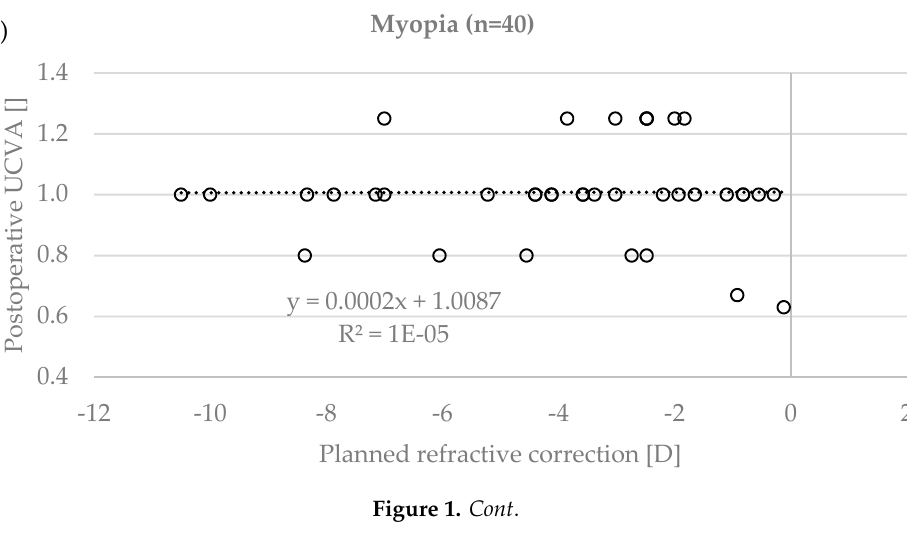
Table 1. Uncorrected visual acuity after regular myopia and Supracor presbyopia treatment.